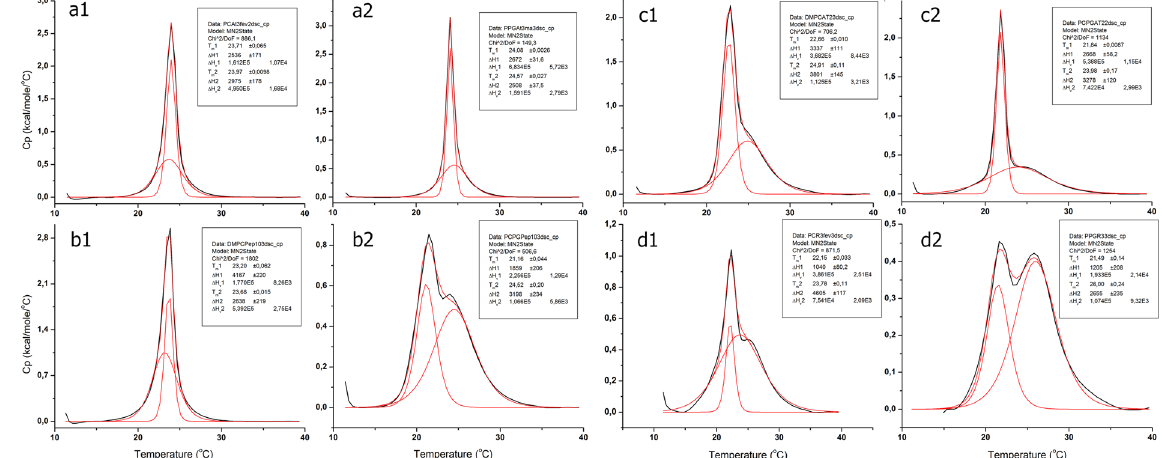
Figure 1. IAPs disturb the main phase transition of DMPC and 2 ∶ 1 DMPC:DMPG model membranes. DSC scans of phospholipid LUVs mixed with 4 mol% peptides. Thermograms were normalized to the lipid mass and the P ′ β → L α transition was fit to a non-two state transition with two peaks. The experimental data are represented as a black line and model fitting is in red. Thermograms for the peptide At03 added to DMPC and 2:1 DMPC:DMPG LUVs are shown in insets ( a1 and a2 ), respectively. Thermograms depicting the effect of peptides Tc10 (insets b1 and b2 ), At02 (insets c1 and c2 ) and Cs02 (insets d1 and d2 ) in the main phase transition of DMPC and 2:1 DMPC:DMPG LUVs, respectively, are also depicted.